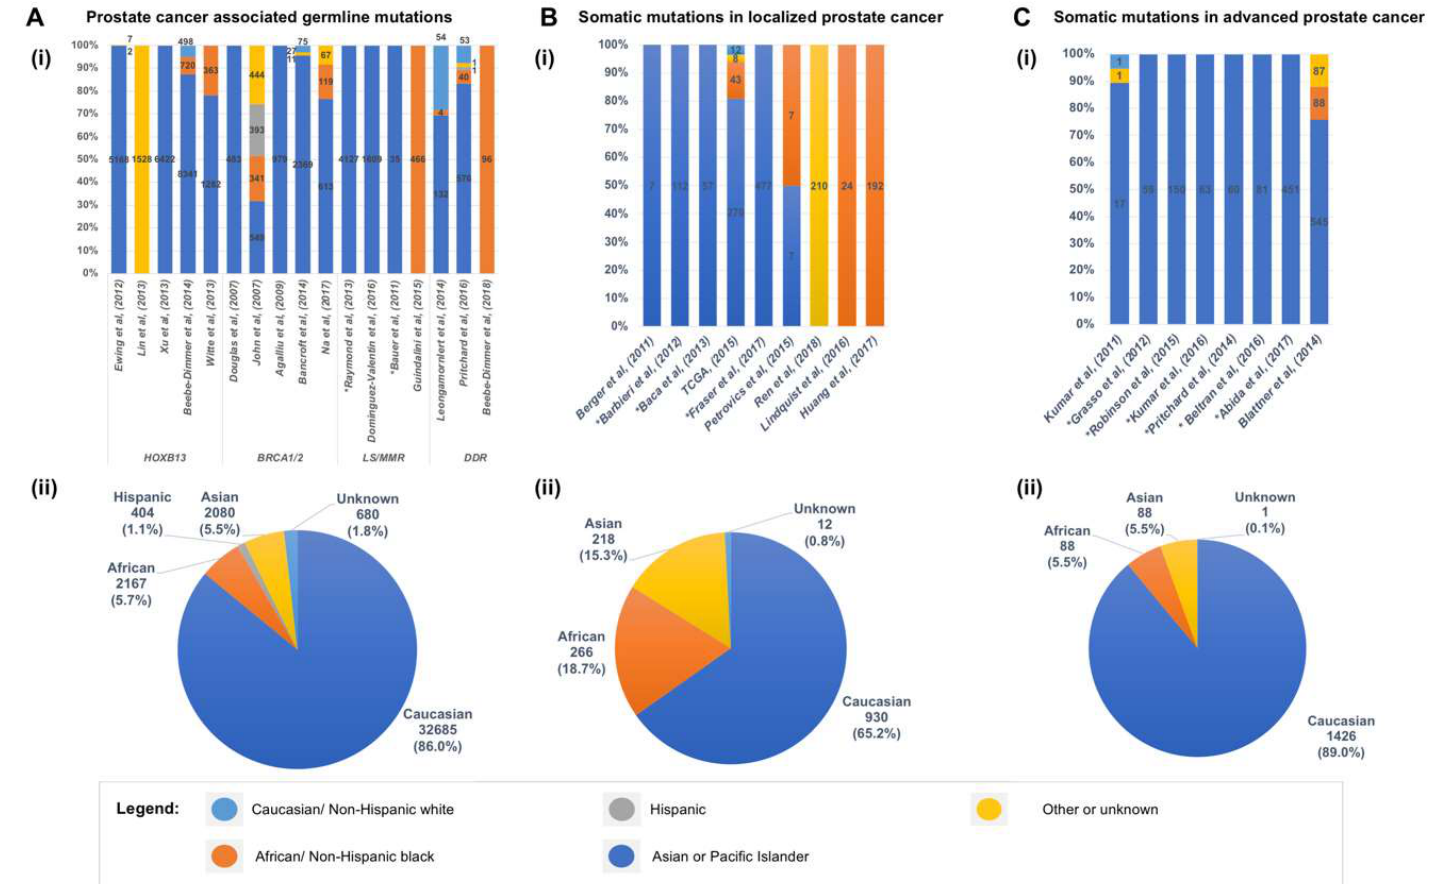
Figure 3. Racial and ethnic disparity in genomic studies of prostate cancer. The distribution of race and ethnicity of cohorts analyzed for germline mutations ( A ), somatic mutations in localized prostate cancers ( B ), and somatic mutations in advanced or metastatic castrate resistant prostate cancers ( C ), in each study reviewed (i), and when grouped together (ii). * In studies which the race or ethnicity of cohort were not specified, the cohort were assumed to be largely Caucasian based on the population of the locale where the study was